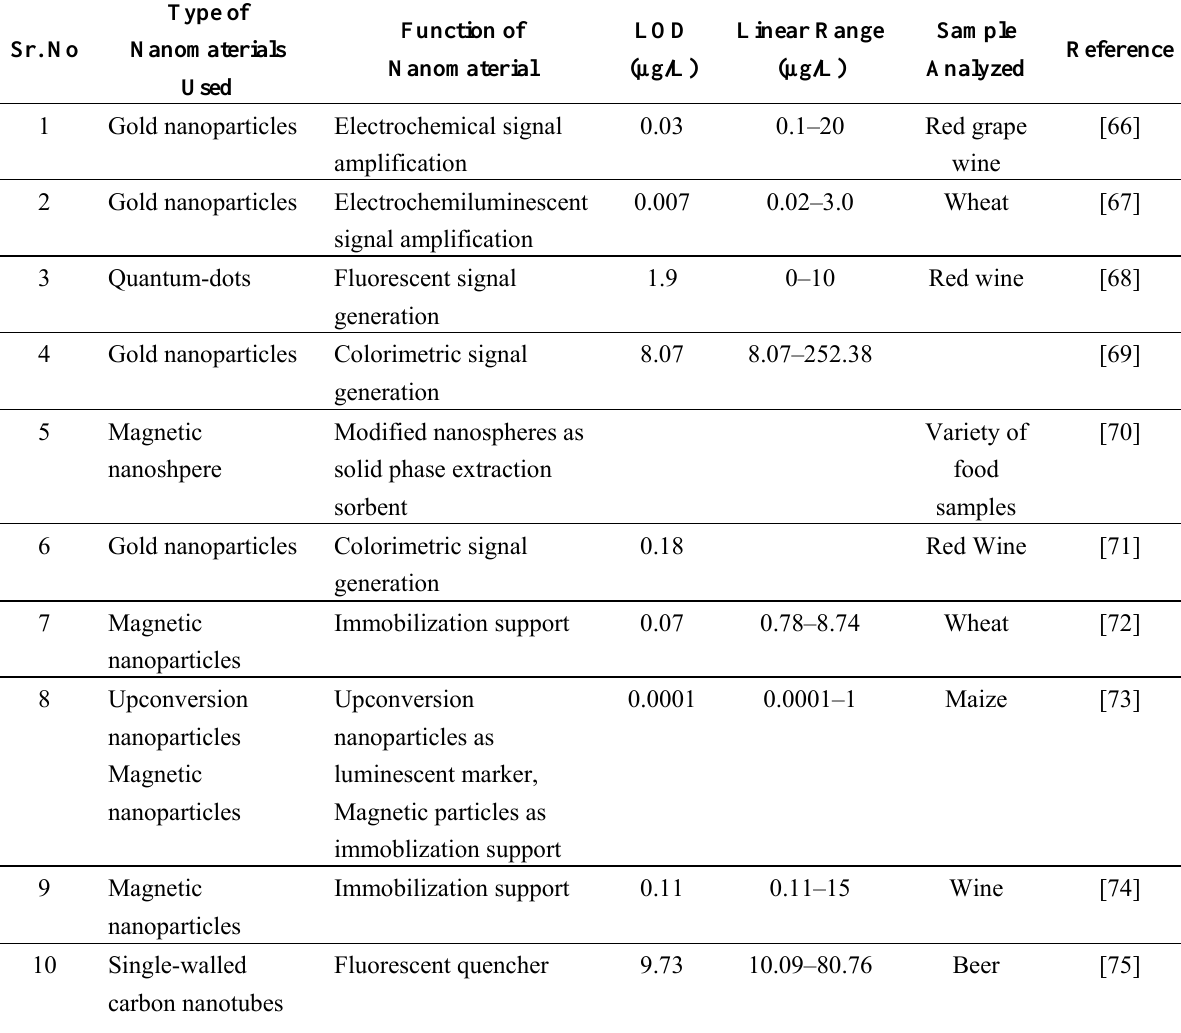
Table 2. Nanomaterials integrated aptamer-based assays for